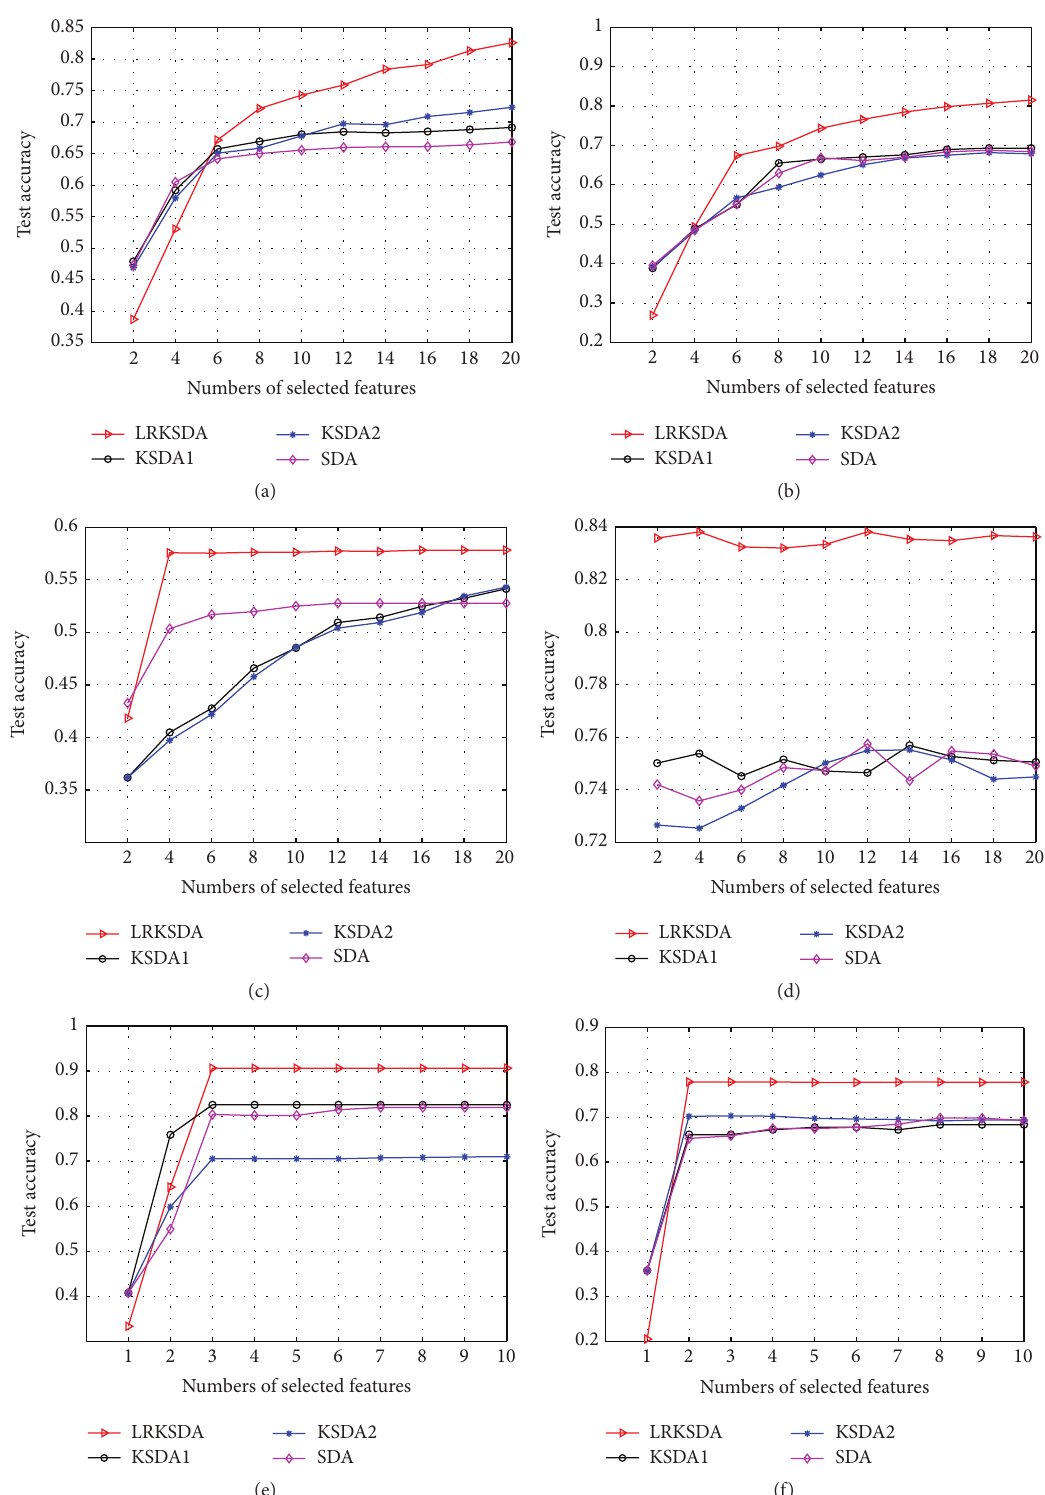
Figure 1: Classification accuracy of different SDA algorithms on the six databases of (a) Extended Yale Face Database B, (b) ORL database, (c) CMU PIE face database, (d) Musk (Version 2) Data Set 2, (e) Seeds Data Set, and (f) SPECT Heart Data